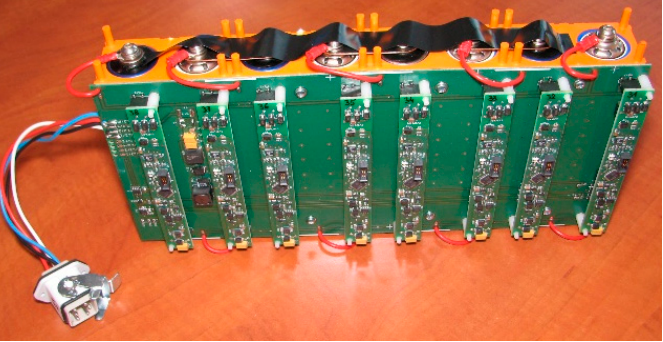
Figure 6. View of the active system (cell to battery) BMS installed on the cells package.